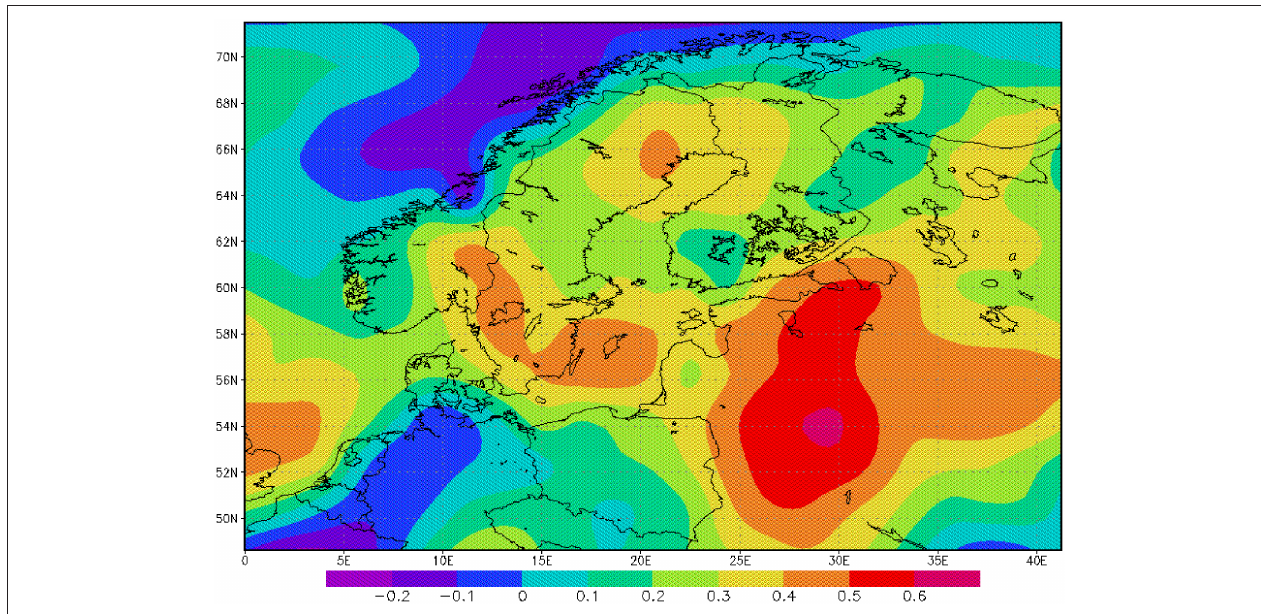
FIGURE 3 | Correlation between AMO and precipitation rate: The correlation is based on monthly mean anomalies for the period